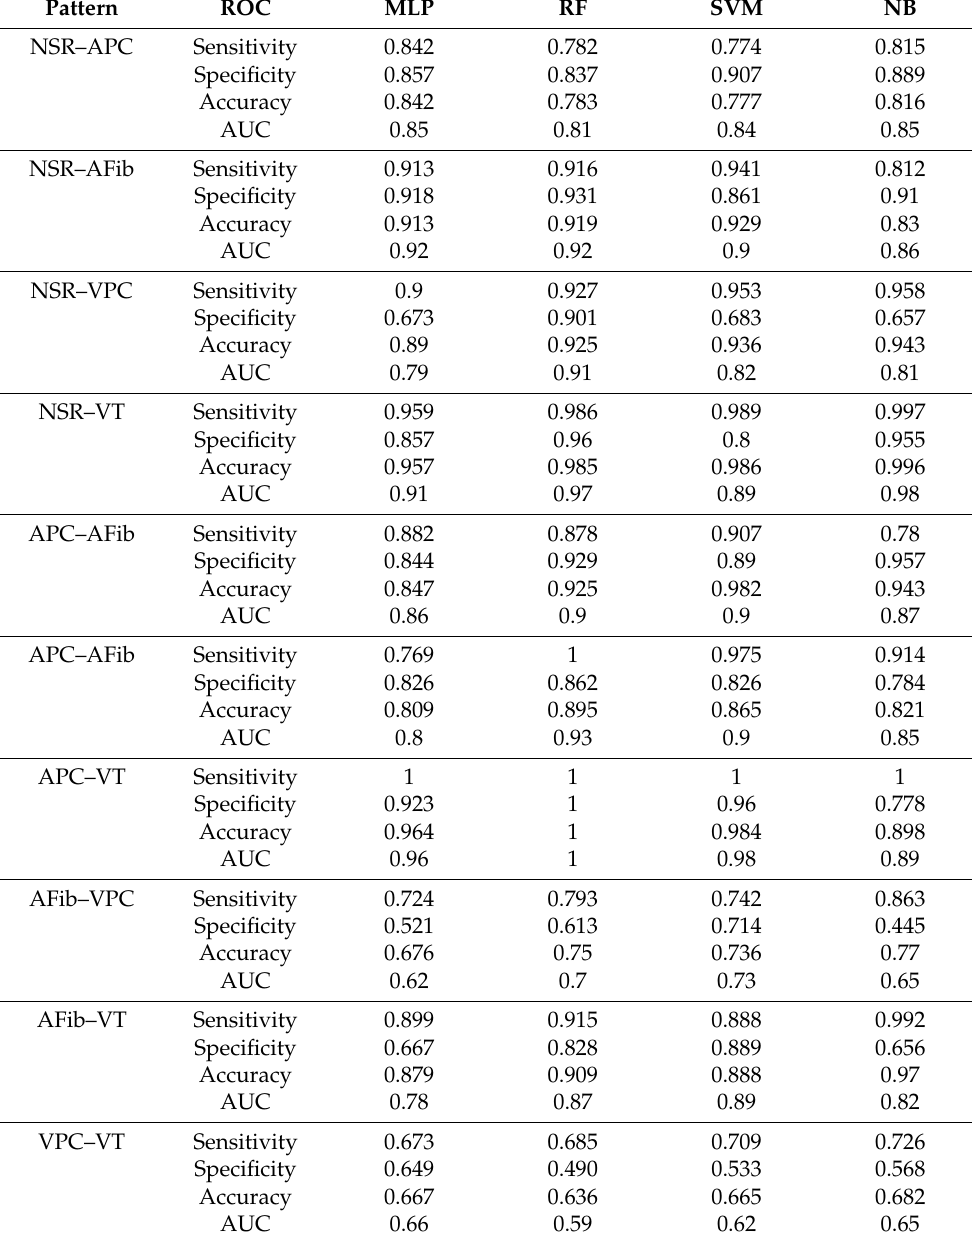
Table 3. Evaluation of the ML models for the patterns of hybrid symptoms due to the training the data set (A) and testing the data set (B), which the pattern labeled by two symptoms (e.g., NSR–APC means normal sinus rhythm versus atrial premature atrial complex) presents their ROC’s results due to the four models (i.e., multiple layer perceptron, random forest, support vector machine, and naive Bayes models) for